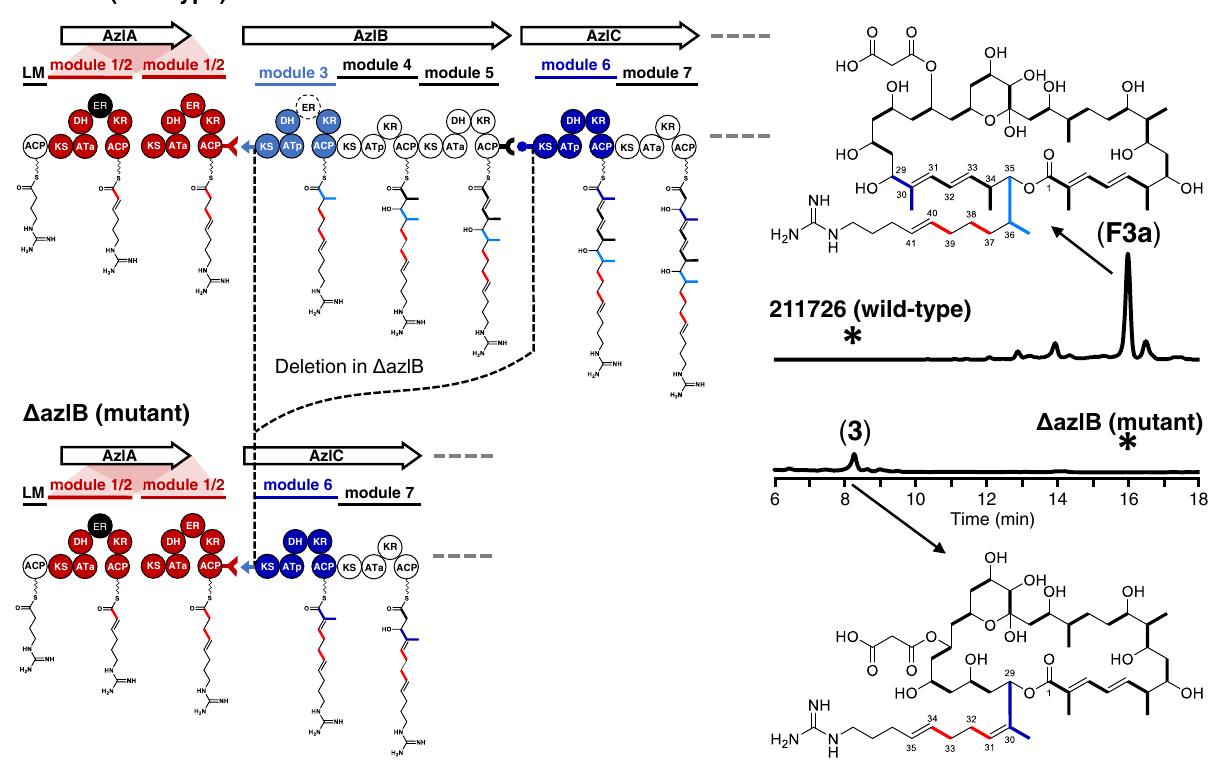
Fig. 4 | Diagram showing azlB deletion when engineering the AZL PKS assembly-line and its product. The dotted circle labeled with ER in module 3 representsthemissingenoylreductasedomainwhoseenoylreductionissuppliedin